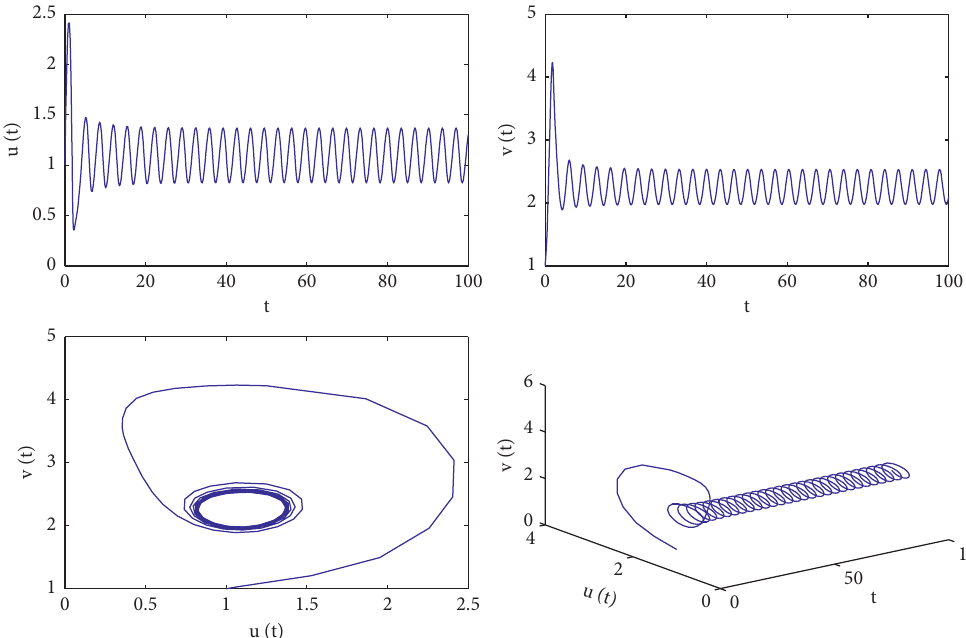
Figure 5: The trajectories graphs and phase graphs of system (94) with τ